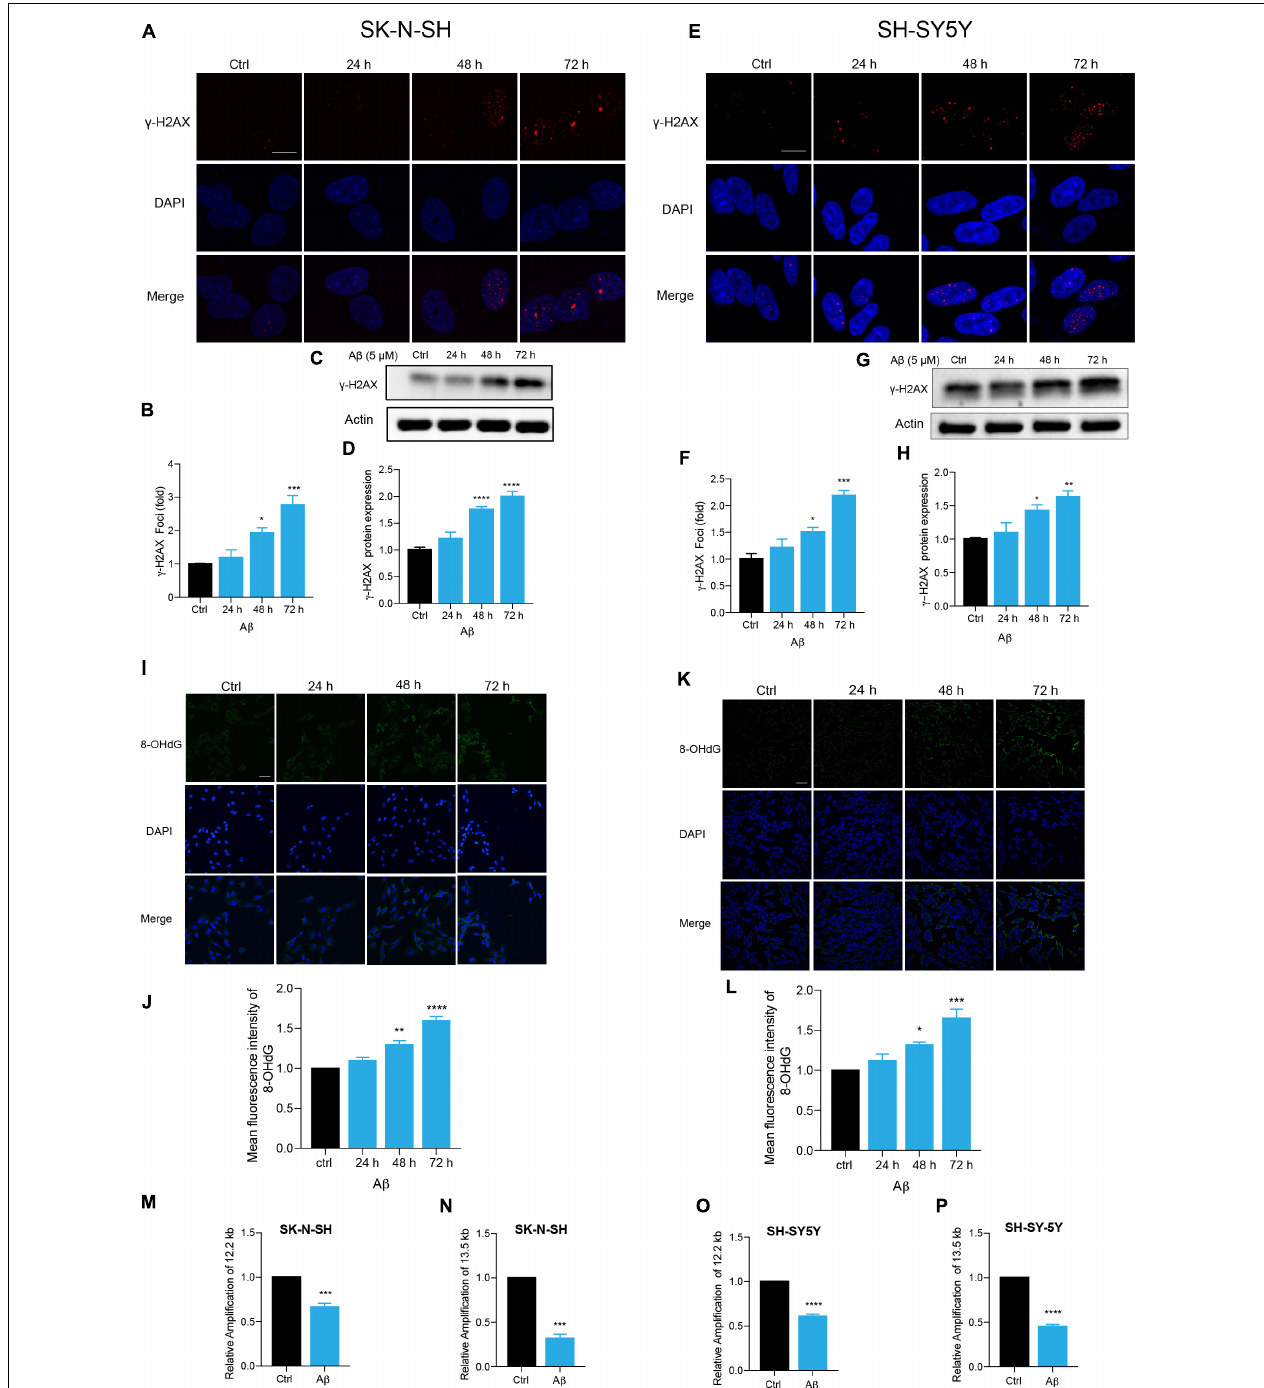
FIGURE 2 | A β induced senescence-associated DNA damage in human neuronal cells. (A,B) Representative images of DAPI and γ -H2AX fluorescent staining in A β (5 µ M)-treated SK-N-SH cells at 24, 48, and 72 h. The quantificative analysis of γ -H2AX foci number in (B) . The pictures were captured by Leica TCS SP8 WLL. Scale bar, 10 µ m. (C,D) Cells were incubated with A β for indicated time in SK-N-SH cells and western blot analysis of γ -H2AX protein in cell lysates (C) . Actin was used as a loading control. Quantification of γ -H2AX protein level in SK-N-SH cells (D) . (E,F) Representative images of DAPI and γ -H2AX fluorescent staining in A β -treated SH-SY5Y cells at 24, 48, and 72 h. The quantificative analysis of γ -H2AX foci number in SK-N-SH cells (F) . The pictures were captured by Leica TCS SP8 WLL. Scale bar, 10 µ m. (G,H) Cells were incubated with A β for indicated time in SH-SY5Y cells, and western blot analysis of γ -H2AX protein in cell lysates (G) . Actin was used as a loading control. Quantification of γ -H2AX protein level (H) . (I,J) Representative images of 8-OHdG staining in SK-N-SH cells treated by A β (5 µ M) at indicated time (I) . The quantification of 8-OHdG fluorescent intensity (J) . The pictures were obtained by Leica TCS SP8 WLL. Scale bar, 50 µ